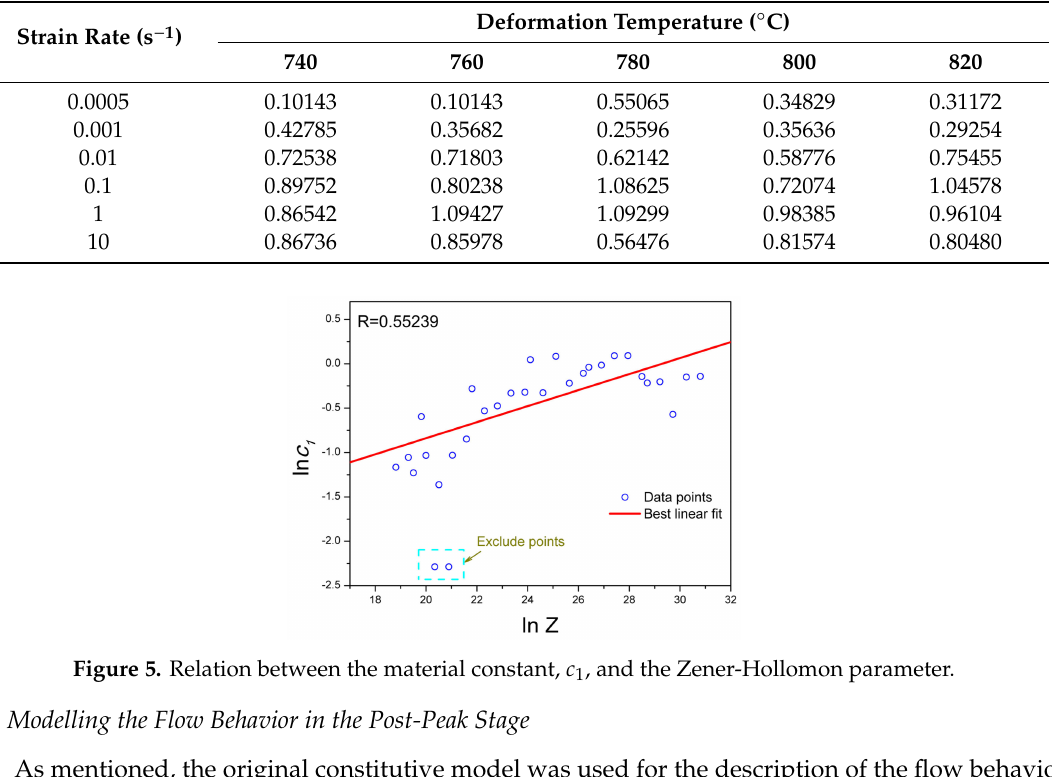
Table 1. The values of the material constant, c 1 , for all tested loading combinations.